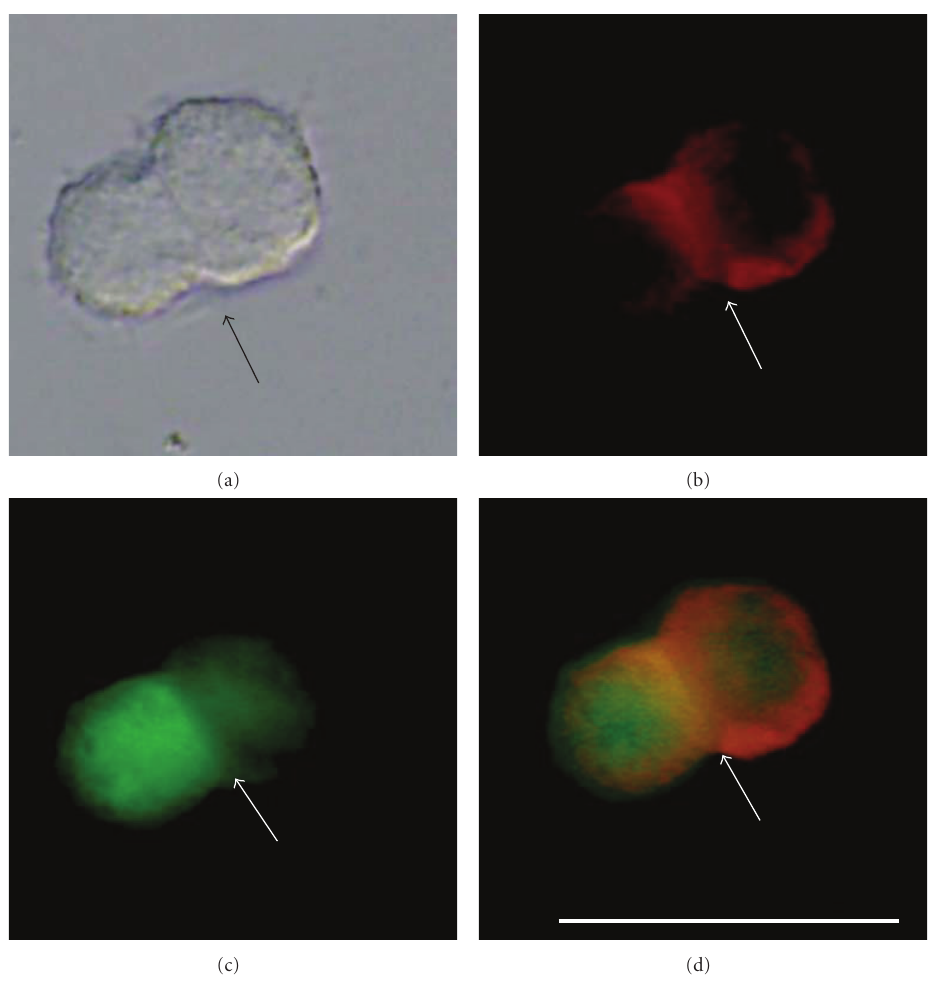
Figure 5: The phosphorylation of GFP/ZYG1 fusion protein by cPKC occurs at the region of cell fusion. Starved GFP/ZYG1 OE cells were developed for 2h in the presence of TPA (5nM). The sample of GFP/ZYG1 OE cells for the immunocytochemical detection was prepared as described in Figure 4. The same fields are shown as images of DIC (a), Rhodamine (b), GFP (c), and GFP and Rhodamine merged (d). Since it is evident by the DIC image that there is no boundary between the two cells (a; black arrow), cell fusion is occurring between two cells. Since the merged image shows yellow color (d; a white arrow), it is evident that GFP/ZYG1 fusion protein and proteins phosphorylated by cPKC are colocalized particularly at the region where cell fusion occurred. Bar: 25 μ